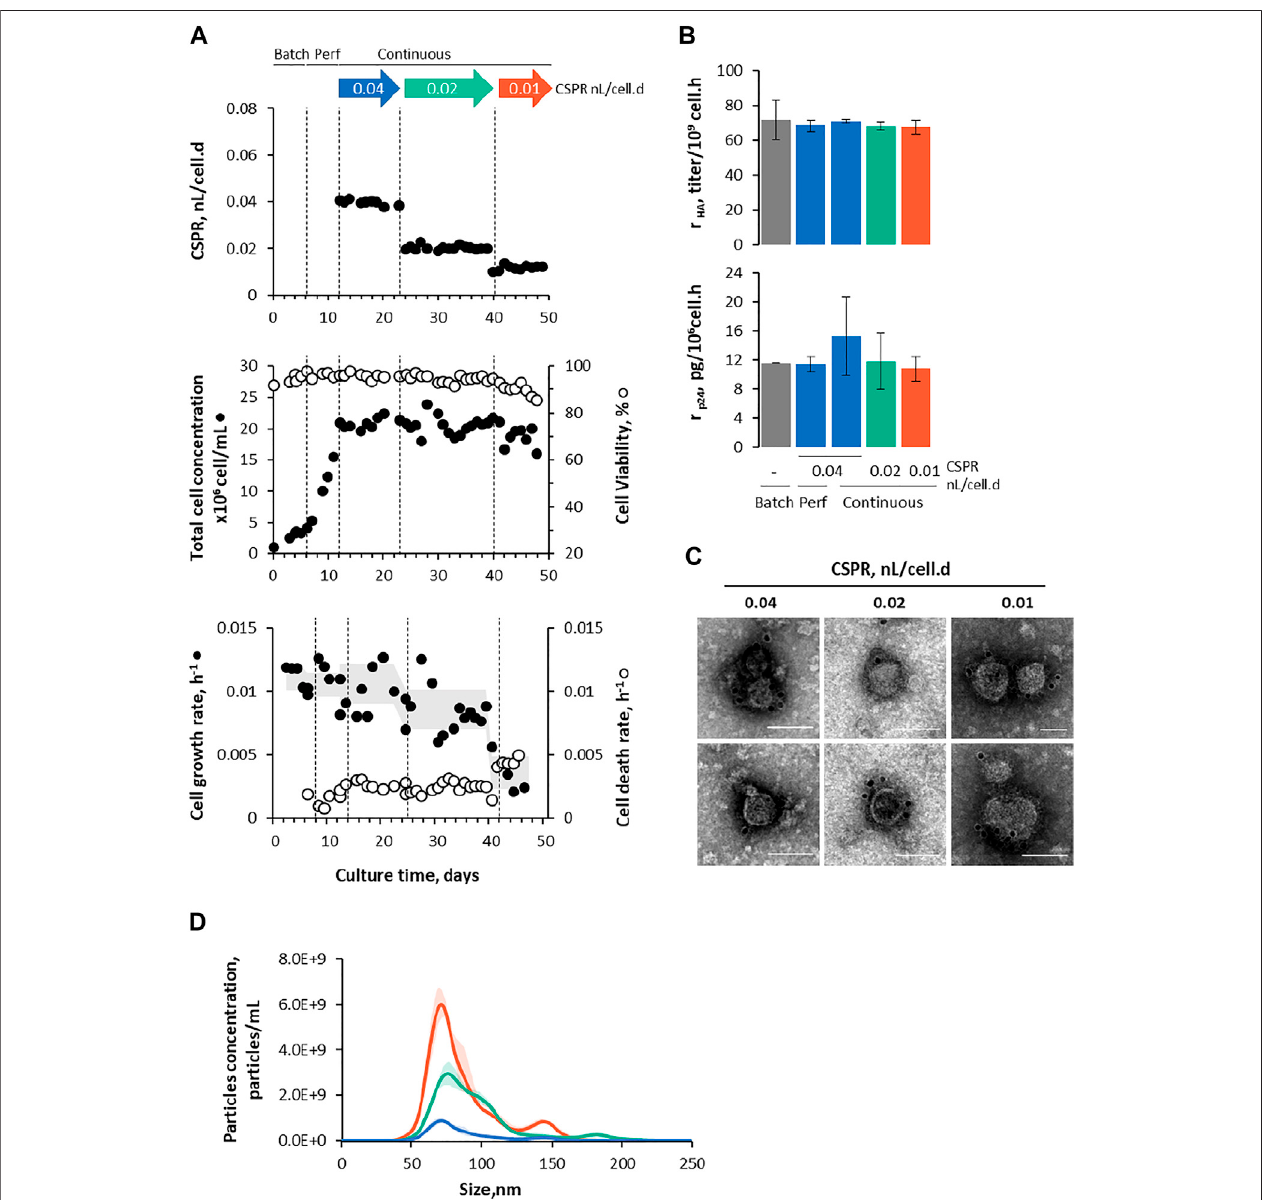
FIGURE3| IntensifyingcontinuousGag-HAVLPexpressionusingATF. (A) Thecell-speci fi cperfusionrate(CSPR),cellgrowthandviabilitykinetics,andcellgrowth and death rate. The shadow under the data point is the average cell growth rate variation along culture time. (B) Speci fi c HA and p24 production at different modes of operation (batch, perfusion, and continuous) and CSPRs. (C) Immunogold staining TEM and (D) nanoparticle tracking analysis from puri fi ed and concentrated Gag-HA VLP samples. Data in bar graphs are expressed as mean ± SD ofone biological replicate using data linearization. One-way ANOVA with post-hoc Tukey ’ smultiple comparison analysis methods. The mean of each column was compared with the mean of the batch; * adjusted p -value < 0.05 was considered statistically signi fi cant. Color code: grey represents data with no cell CSPR, blue represents data under CSPR of 0.04 nL/cell.d, green represents data under CSPR of 0.02 nL/cell.d, and orange represents data under CSPR of 0.01